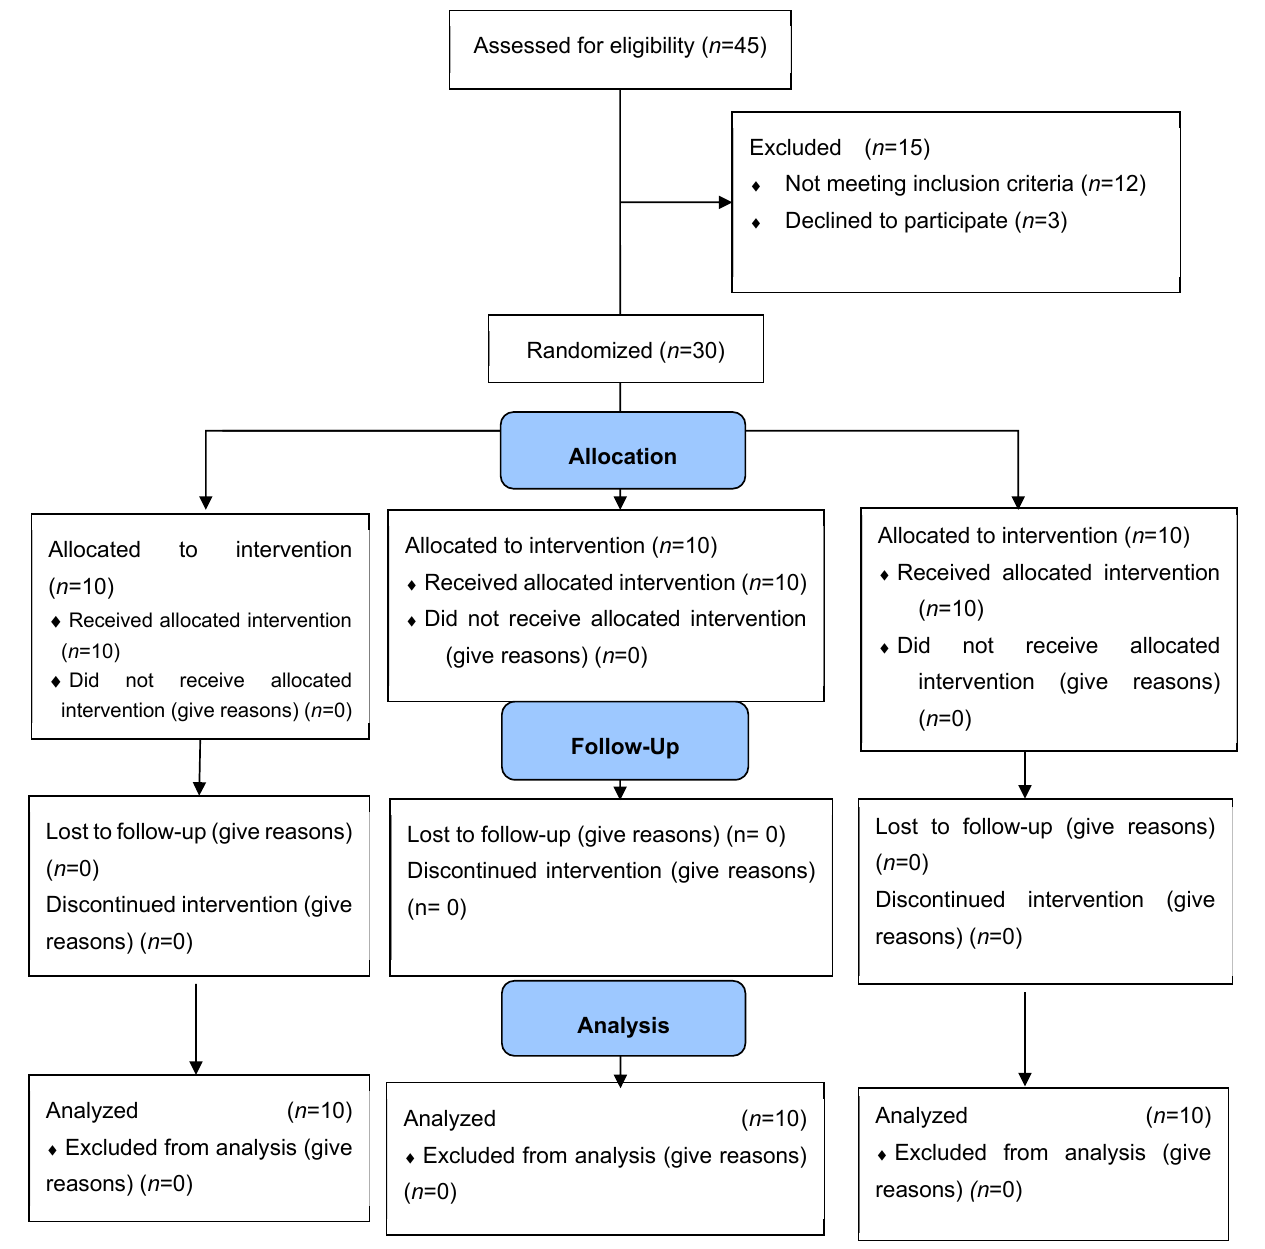
Figure 1. CONSORT flow diagram.